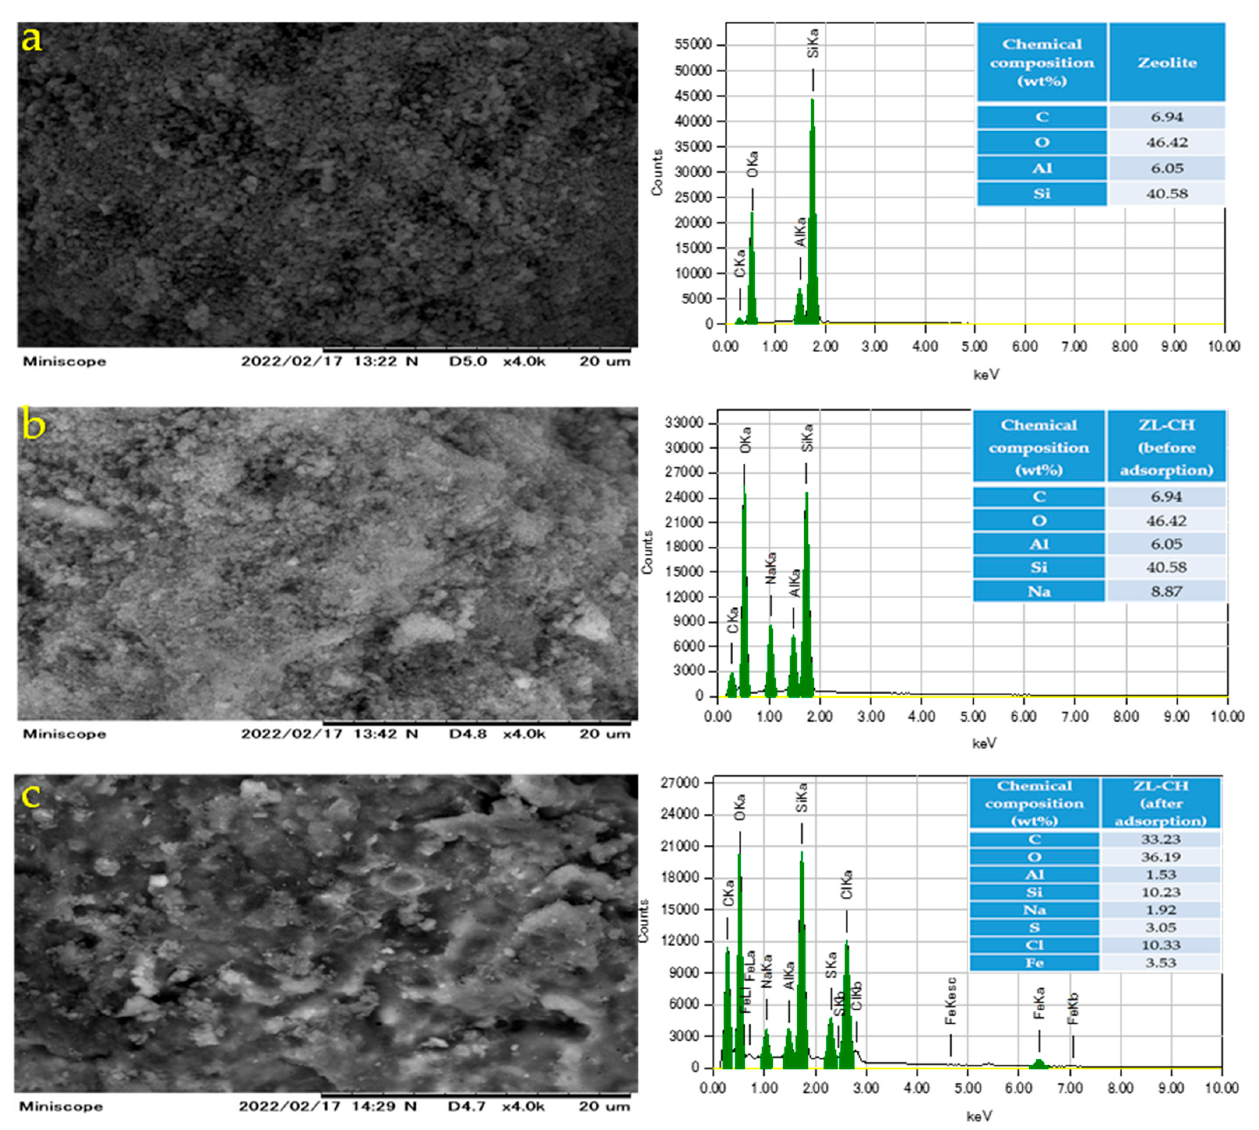
Figure 1. Morphology of adsorbent. SEM images (left) and EDS spectra (right). ( a ) Zeolite; ( b ) dry